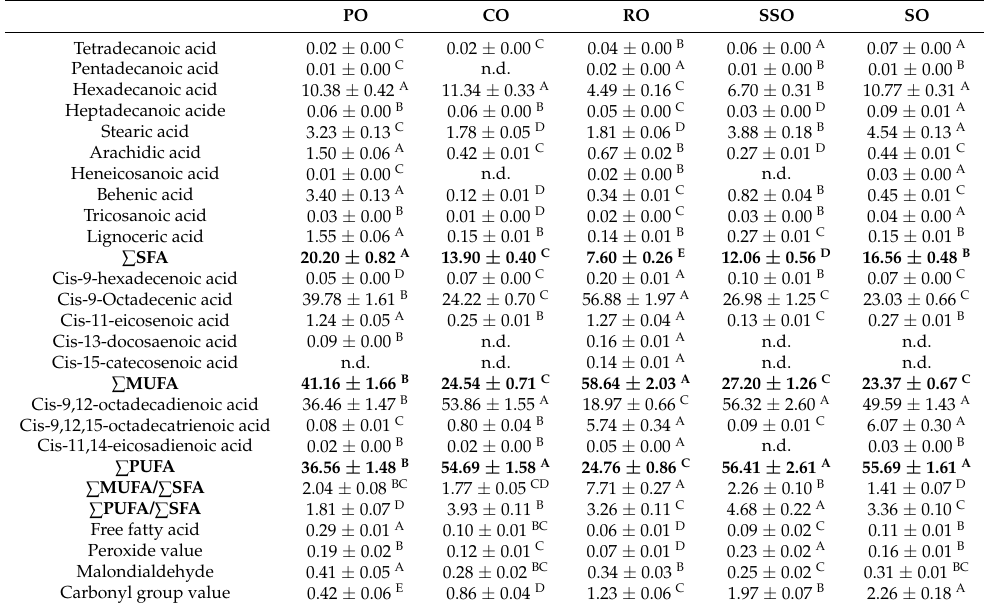
Table 1. Fatty acid composition (%), free fatty acid (%), peroxide value (meq O 2 /kg), malondialde- hyde (mg/kg), and carbonyl group value (meq/kg) of the different vegetable oils.